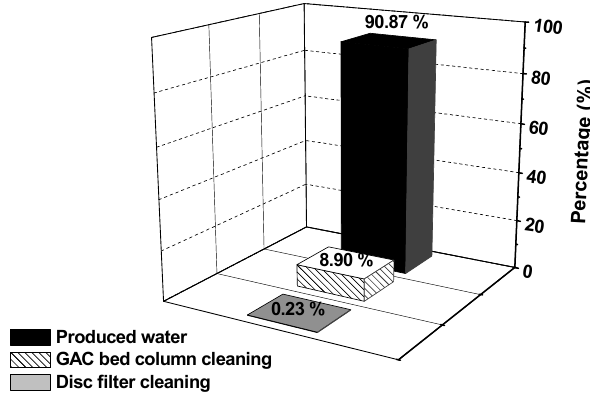
Figure 3. Percentages of produced water, granular activated carbon (GAC) bed column cleaning and disc filter cleaning from total treated volume.